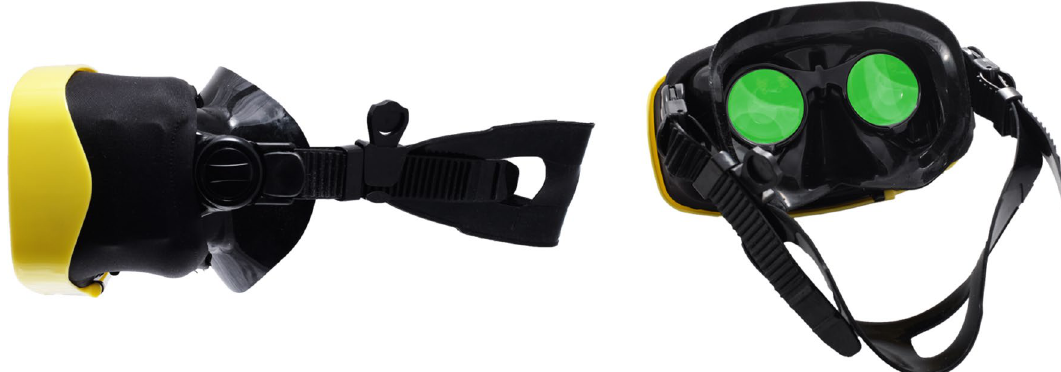
Figure 3. DIVR headset. Image courtesy of Ballast Technologies,